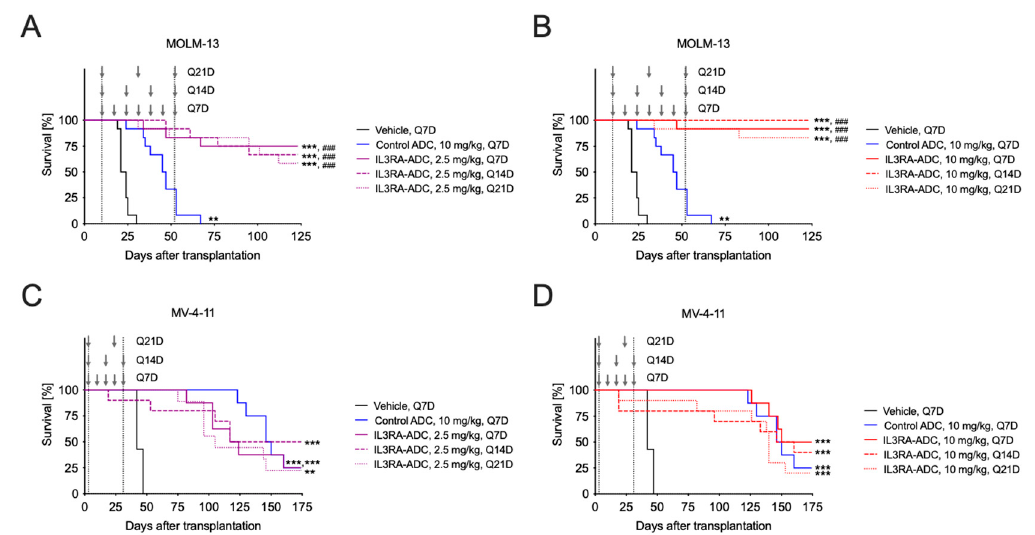
Figure 2. Antitumor efficacy of the IL3RA-ADC BAY-943 in the systemic MOLM-13 and MV-4-11 leukemia xenograft models. A-B. Kaplan–Meier survival plots of mice transplanted with the MOLM-13 human acute myeloid leukemia (AML) cells and treated intravenously (i.v.) with the isotype control ADC (10 mg / kg, Q7D) or IL3RA-ADC at 2.5 mg / kg ( A ) or 10 mg / kg ( B ); Q7D, Q14D, or Q21D. C-D. Kaplan–Meier survival plots of mice transplanted with the MV-4-11 human biphenotypic leukemia cells and treated i.v. with the isotype control ADC (10 mg / kg, Q7D) or IL3RA-ADC at 2.5 mg / kg ( C ) or 10 mg / kg ( D ); Q7D, Q14D or Q21D. The vertical dashed gray lines delineate the treatment period, and the arrows indicate time of treatment. Data were analyzed using the Cox proportional hazards model and corrected for family-wise error rate using Sidak’s method. Asterisks and hashtags indicate statistical significance in comparison to the vehicle (** p < 0.01, *** p < 0.001) or isotype control ADC (### p < 0.001).